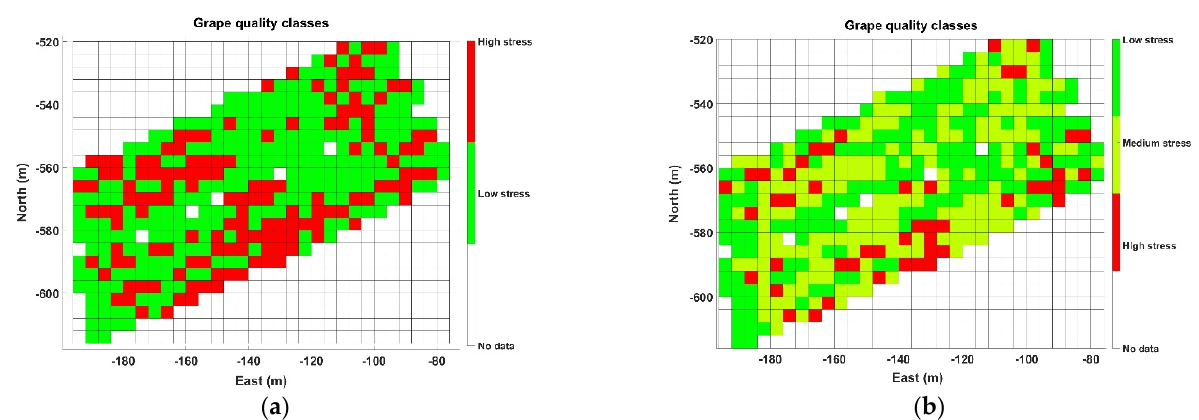
Figure 11. Map A harvesting zones output by the k-means algorithm: ( a ) two zones; and ( b ) three zones.